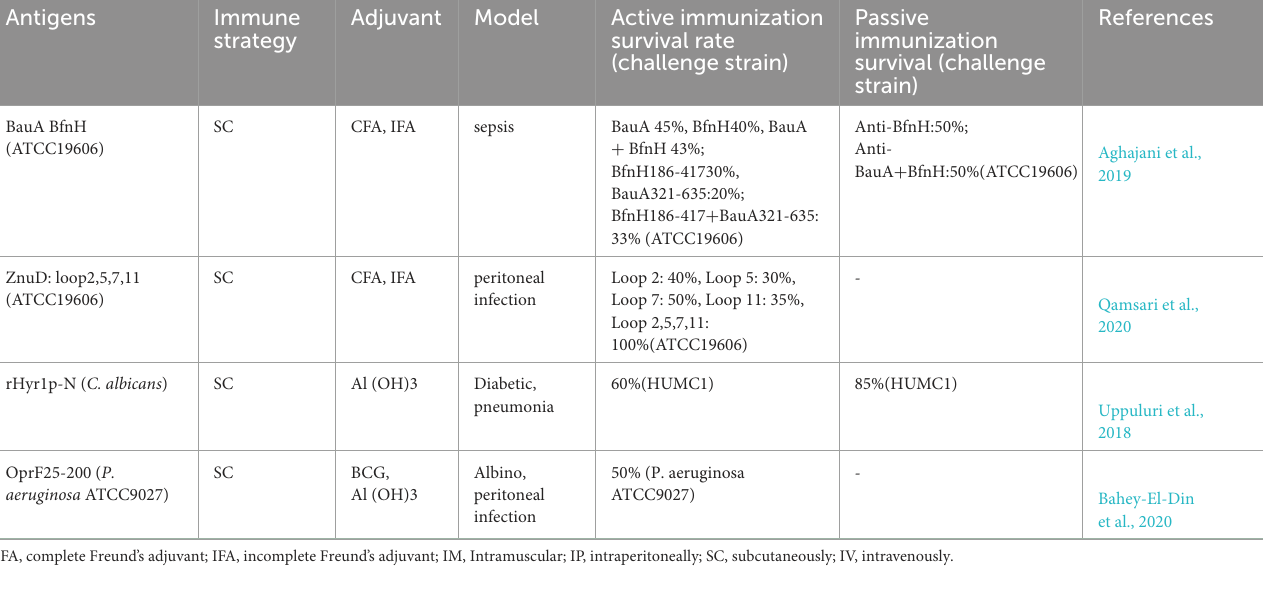
and the combined vaccine plan did not produce a synergistic effect (Bolourchi et al.,